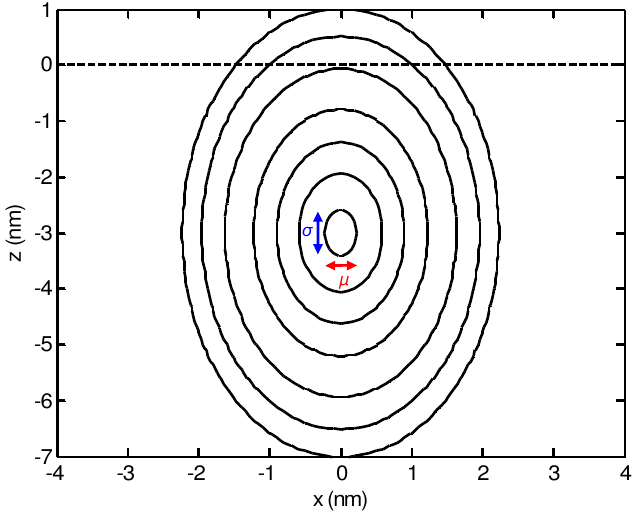
Figure 1. Contour plot of the deposited energy in the x - z plane according to equation (17) with a = 3 nm, σ = 0 . 9 nm, µ = 0 . 5 nm, and E = 500 eV. The surface at z = 0 is indicated by the broken line.